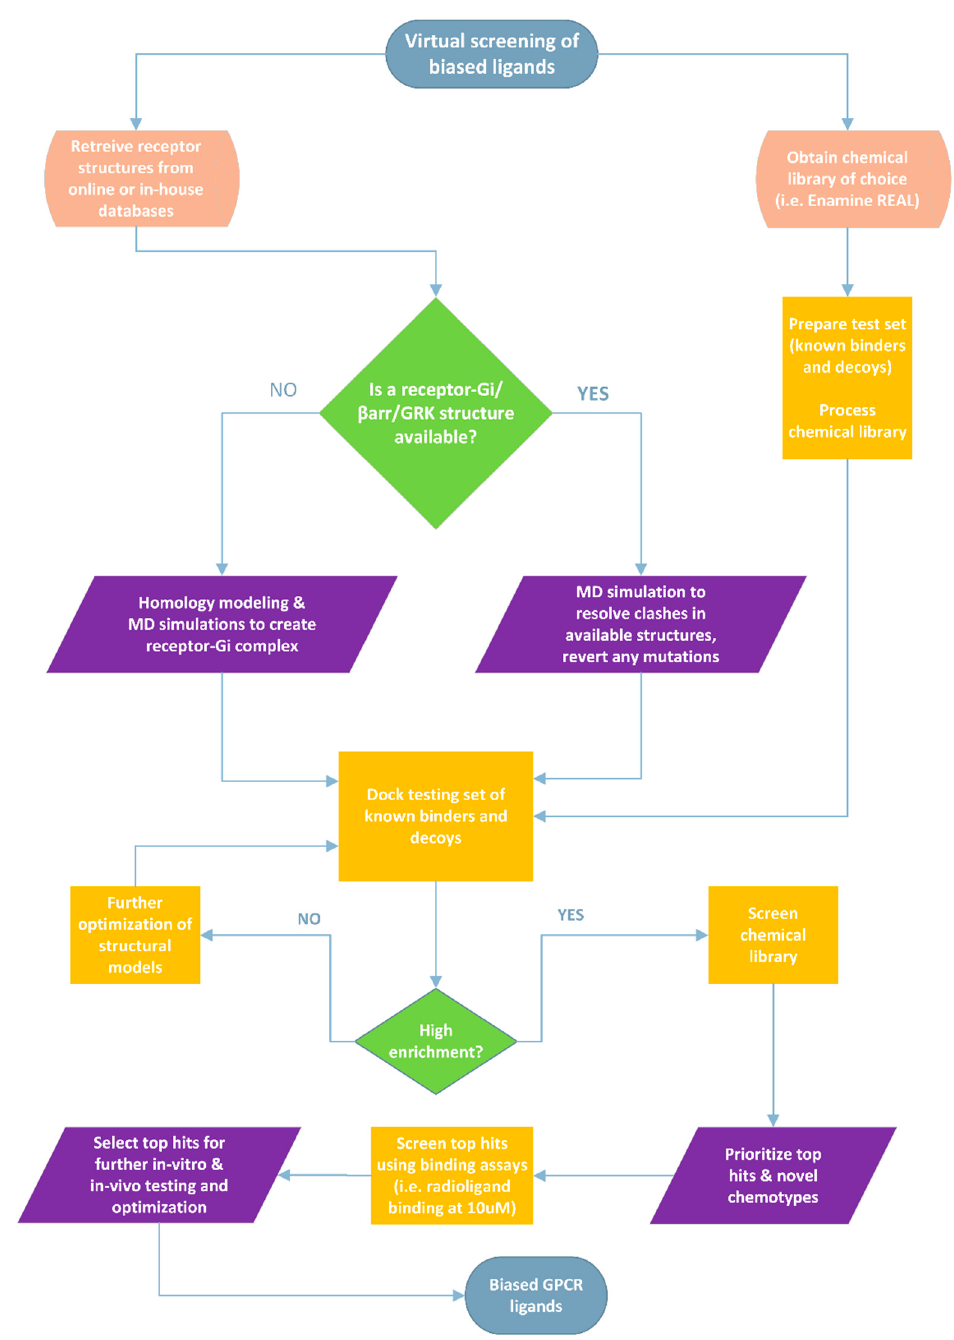
Figure 3. Proposed workflow for screening large chemical libraries to identify G-protein biased agonists at the δ OR and other GPCRs. A similar workflow could be applied to identify GRK- or β - arrestin-biased small molecules given that high-quality crystal or cryo-EM structures are available. In cases where distinct interactions or sub-pockets specific to biased agonists or in cases where we know that an allosteric site/pocket could lead to biased effects, we could restrict ligand docking to that specific site to screen a given chemical library. The most accurate way to confirm such interactions would be to resolve high-quality structures and/or perform mutagenesis studies. Alternatively, enhanced sampling computational modeling to model receptor-effector complexes could be useful if computational cost is not a limiting factor.